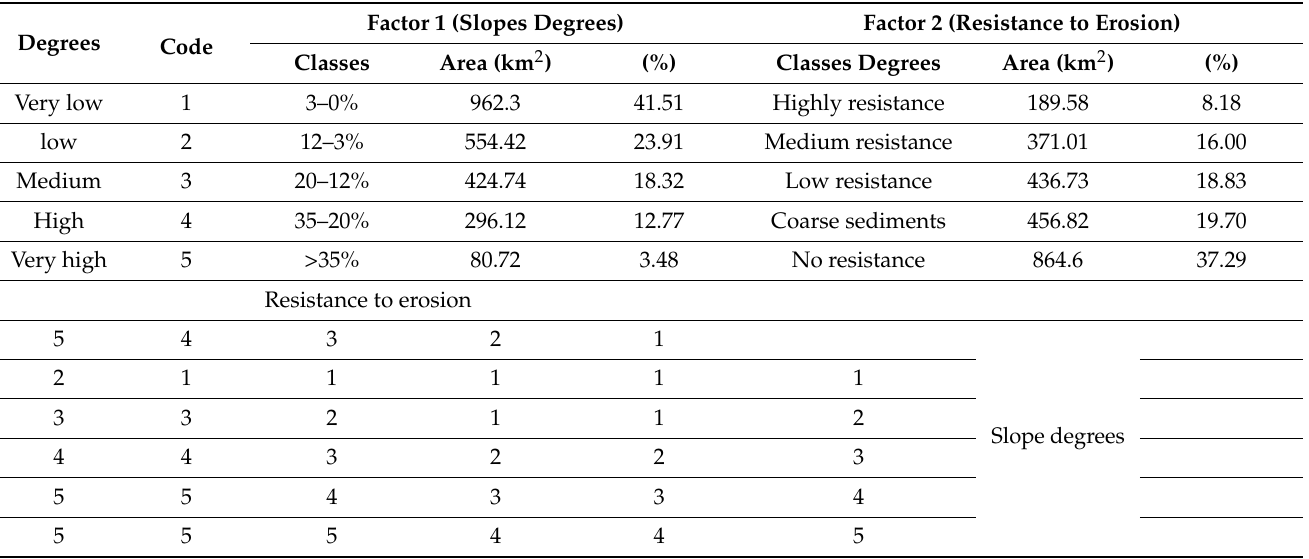
Table 2. Correlation matrix of resistance to erosion and slope degrees according to PAP/RAC model.